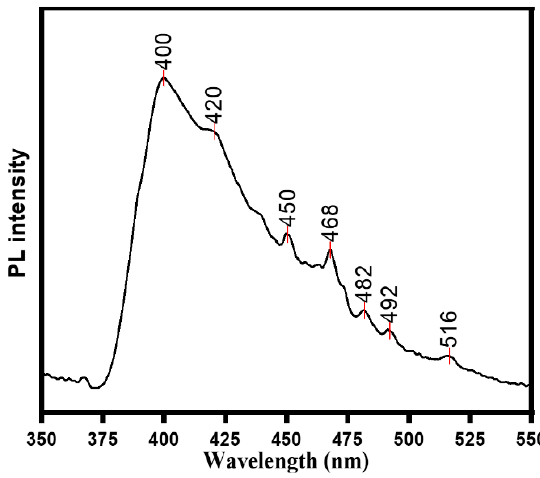
Figure 5. The photoluminescence (PL) spectra of LP-ZnO NPs.